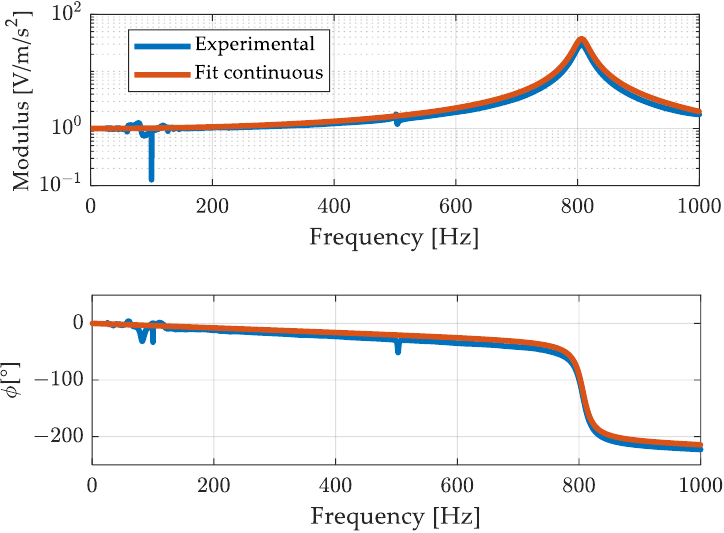
Figure 10. Experimental frequency response function and its fit with a two-poles, two-zeros continu- ous time model.